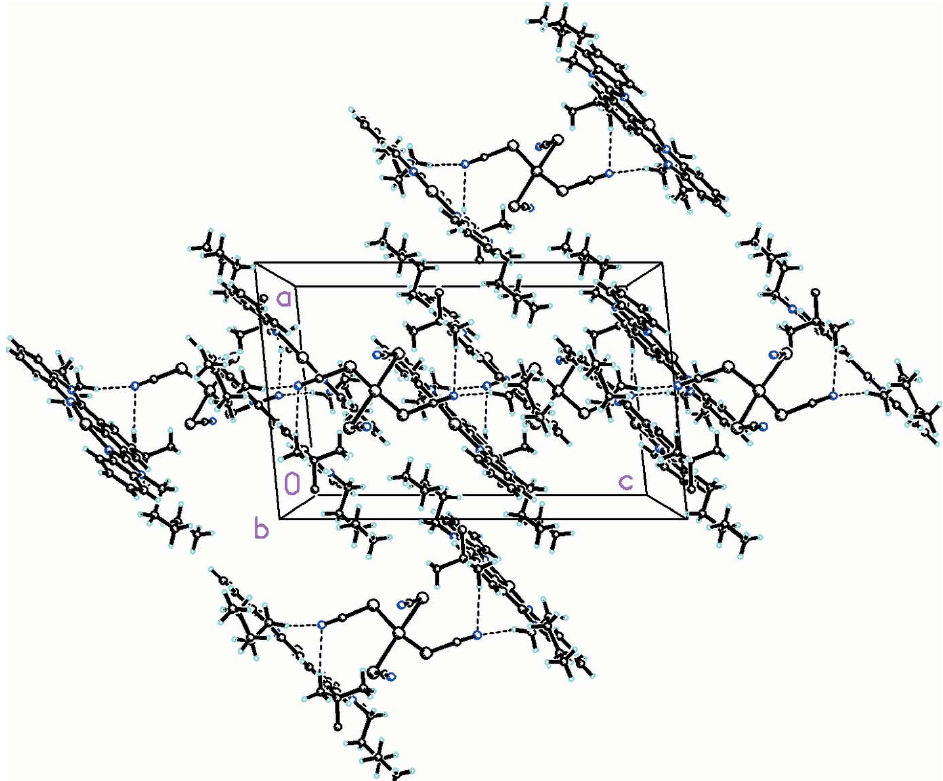
Figure 2 Packing diagram viewed along the b axis. C—H (cid:3)(cid:3)(cid:3) N interactions linking the cations and anions are shown as dashed lines. Only the major disorder component is shown for clarity.